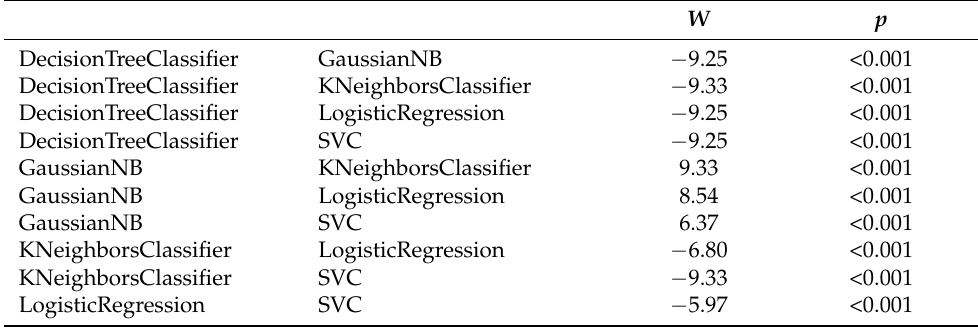
Table A8. The results of the Dwass-Steel-Critchlow-Fligner pairwise comparisons for test